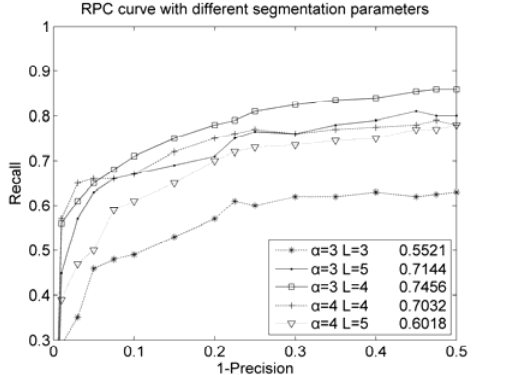
Figure 5. Detection performance (RPC and AUC) with different segmentation parameters